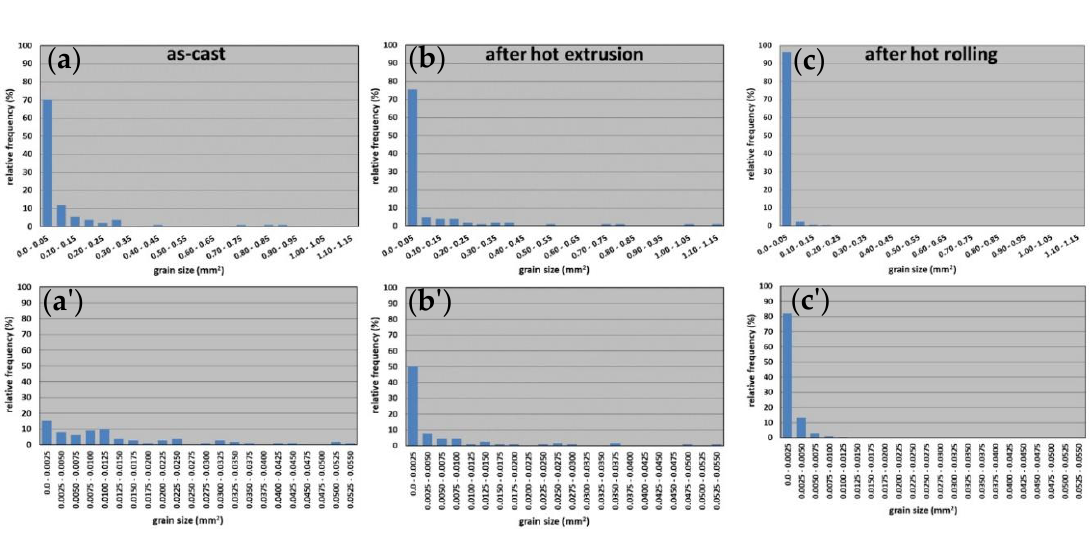
Figure 5. Grain size distribution for the FeAl alloy, ( a ) ( a’ ) as-cast, ( b ) ( b’ ) after hot extrusion, ( c ) ( c’ ) after hot rolling.